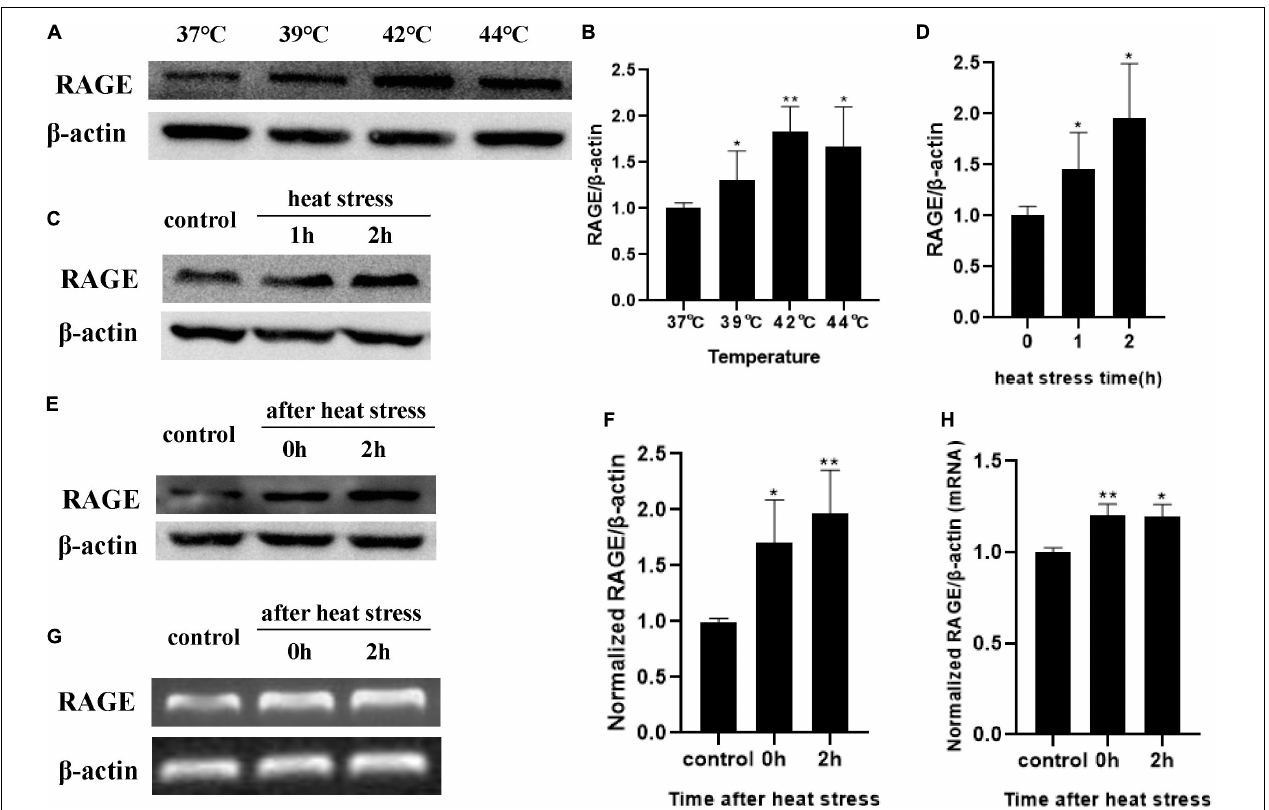
FIGURE 3 | Influences of heat stress on RAGE mRNA and protein expression. HUVECs were subjected to heat stress at different conditions, and cells were harvested at a different time point after heat exposure and analyzed by western blot or RT-PCR. (A,B) HUVECs were subjected to heat stress at 37, 39, 42, or 44 ◦ C for 2 h. RAGE protein expression increased in a temperature-dependent manner. (C,D) HUVECs were exposed to 42 ◦ C for 1 or 2 h. Samples were harvested 2 h after heat stress. RAGE protein expression increased in a time-dependent manner. (E–H) Samples were harvested immediately or 2 h after 2 h of heat stress at 42 ◦ C and the mRNA level and protein level of RAGE increased immediately after heat stress (* P < 0.05, ** P < 0.01 vs